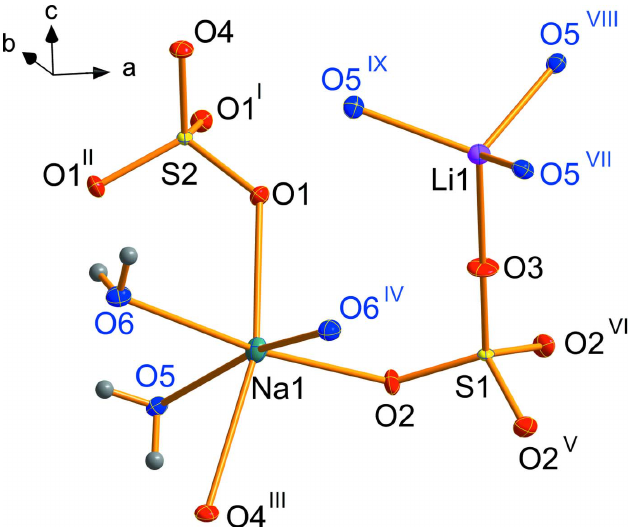
Figure 2 Asymmetric unit plus bonds. Ellipsoids are drawn at the 50% level.